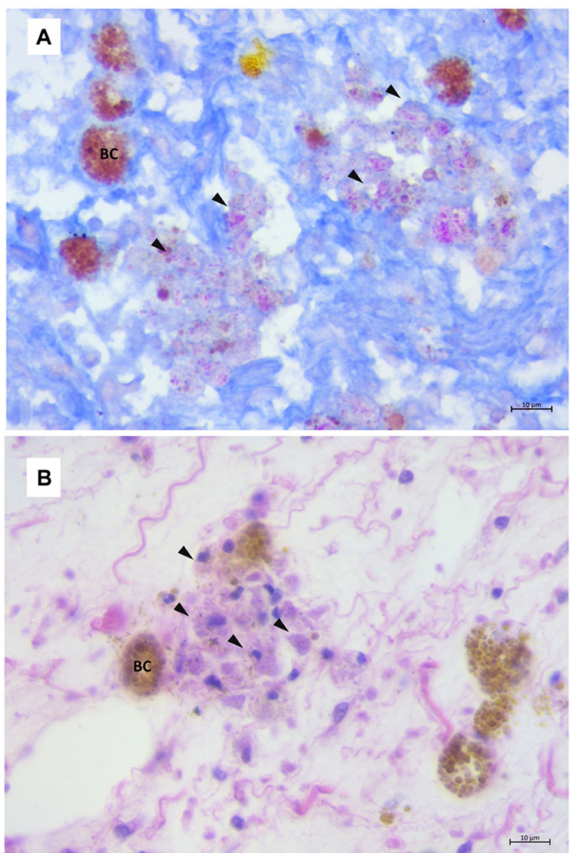
Figure 1. Histopathology of mycobacteriosis in pen shell ( Pinna nobilis ) tissues. ( A ) Infection at the level of the connective tissue circumscribing the digestive gland with immune cell aggregates filled with Ziehl–Neelsen-positive bacteria (arrowheads) and phagocytosed by active brown cells (BC). ( B ) Mycobacteria appear slightly basophilic in haematoxylin and eosin